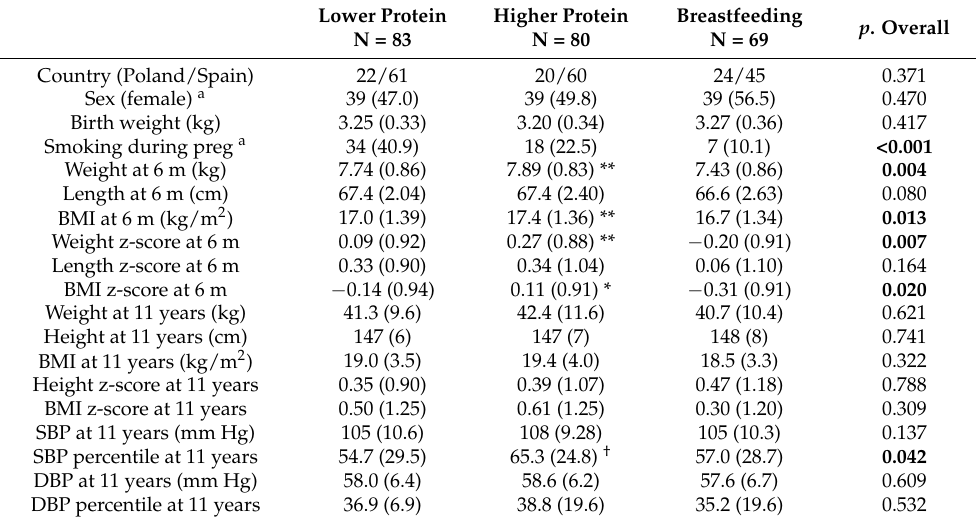
Table 1. Population characteristics at baseline as well as anthropometric measurements and blood pressure (mean (SD)) according to feeding group in 232 children who underwent a kidney ultrasound at 6 months and 11 years of age.